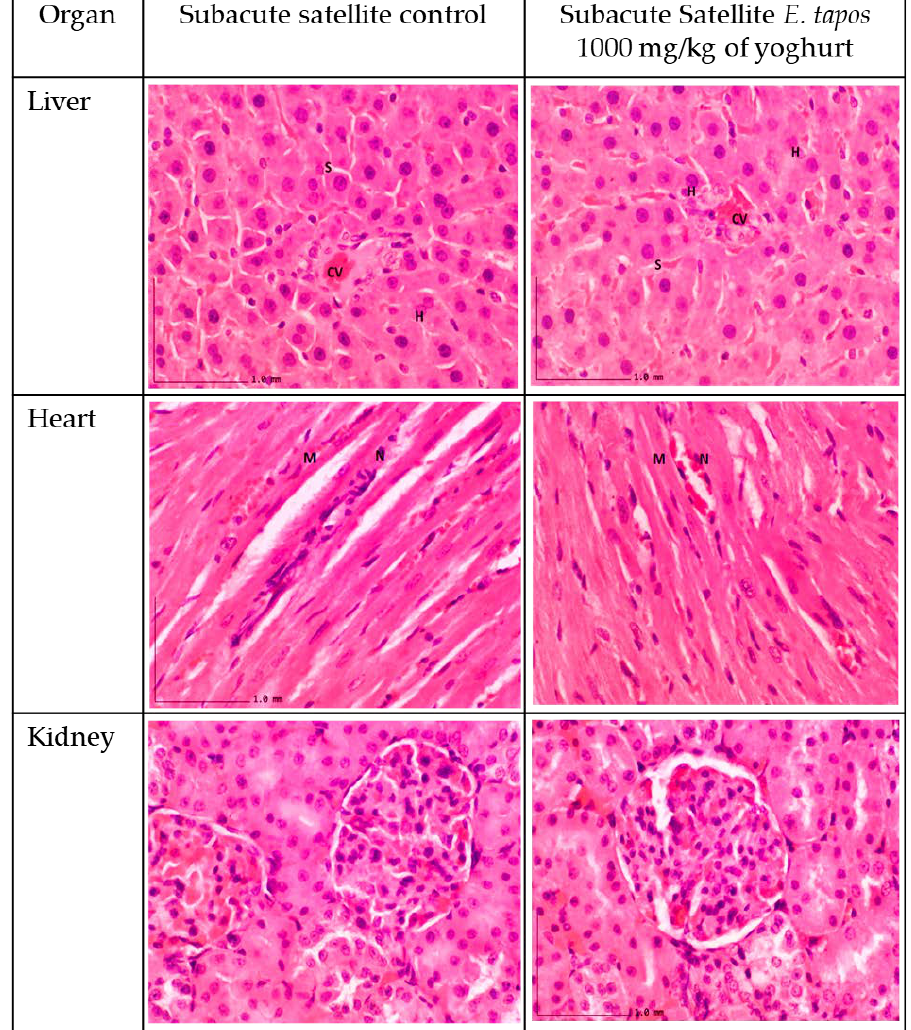
Figure 3. The histology section of satellite groups. The liver section shows standard strands of hepatocytes (H), sinusoids (S), and central vein (CV). It showed 0% of biopsied hepatocytes affected. The liver grading scores were recorded as 0 due to absence of steatosis, lobular inflammation, and hepatocyte ballooning. The heart tissue shows normal architecture, and no inflammation was seen. Myocardium (M) and nucleus (N). Kidney histology show no lesion nor tubular dilation with a normal structure of renal corpuscle.